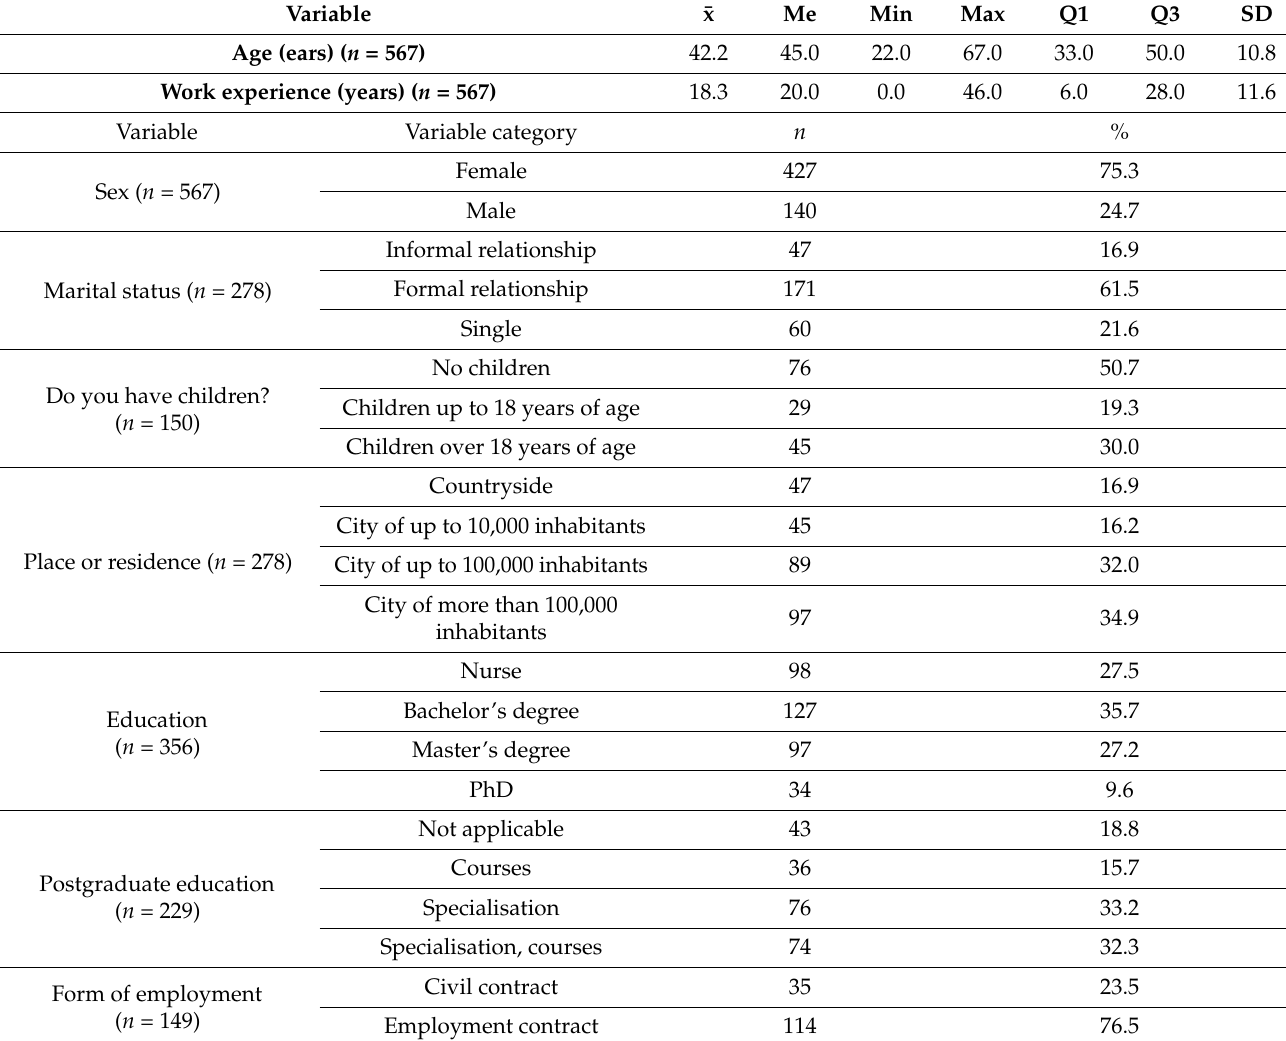
Table 1. Sociodemographic and clinical characteristics of the study